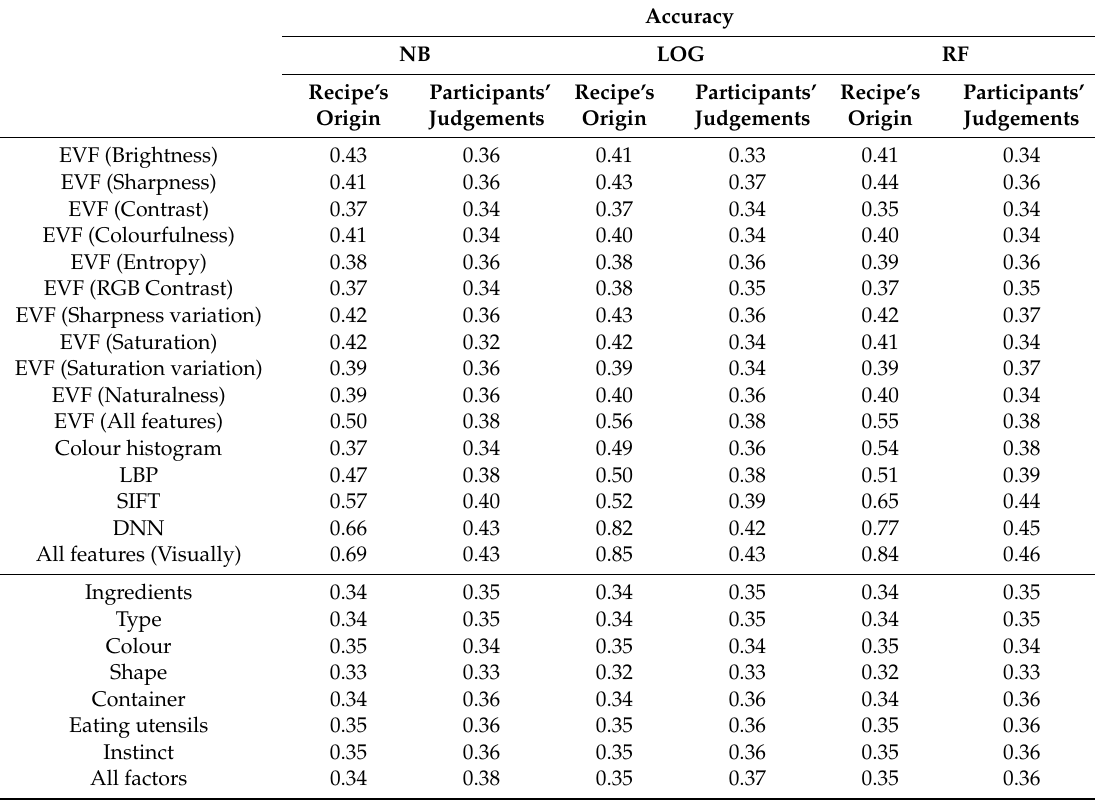
Table 3. Results when predicting recipe image source and participant-applied label based on di ff erent visual properties and other factors. Best performing scores for each classifier are bolded. NB = Naive Bayes; LOG = Logistic Regression; RF = Random